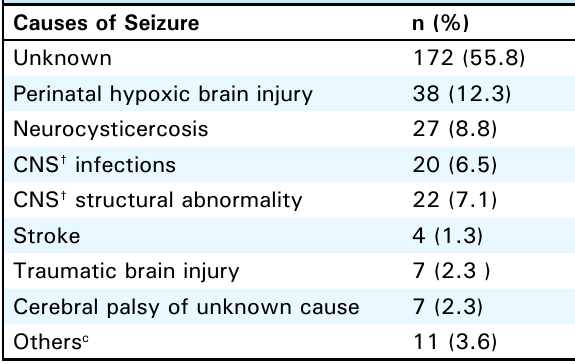
Table 3. Causes of seizures.